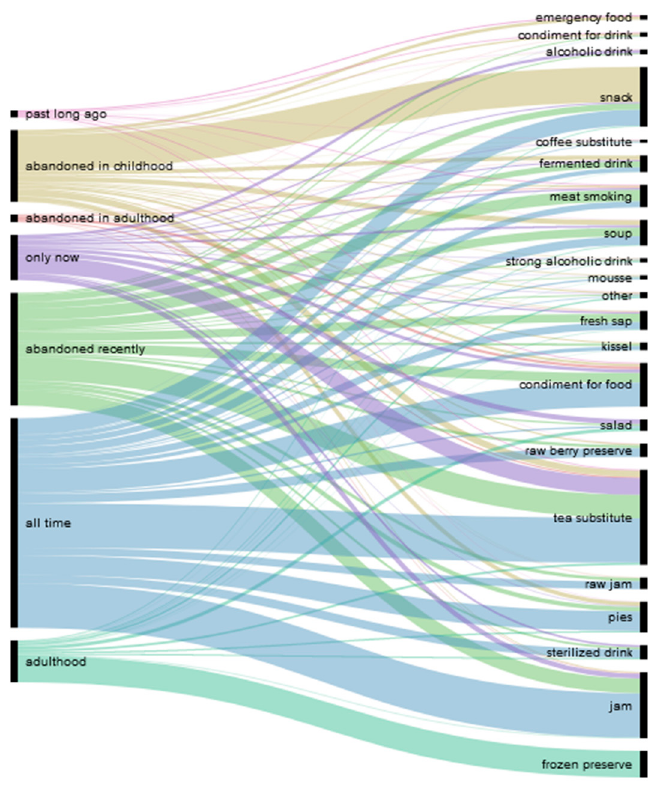
Figure 4. Diachronic distribution of the dishes prepared over the lifetime of the study participants. “ Yes, I freeze it. No, sometimes I make a bit of jam simply […] generally I freeze the bilberry ” (F, Seto, b.